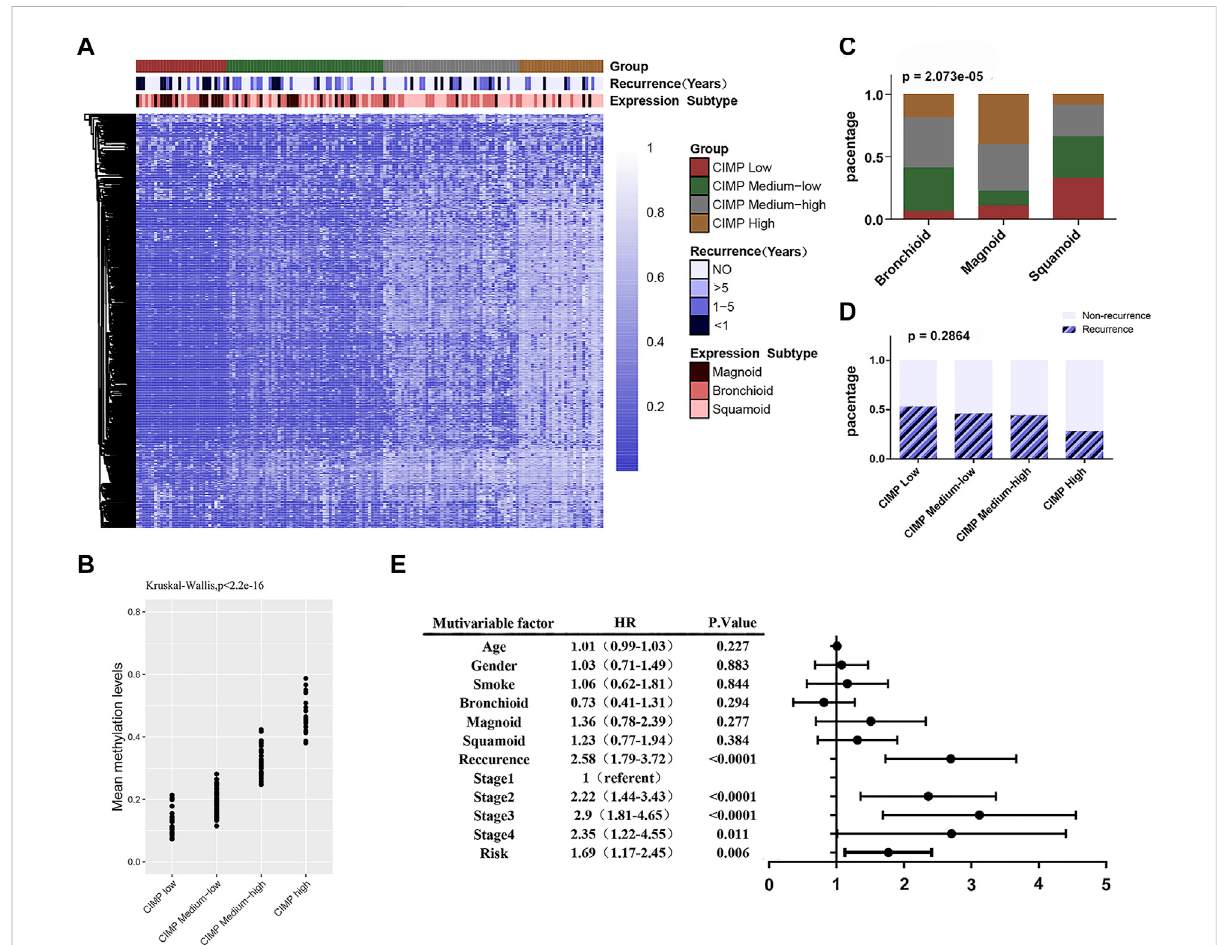
FIGURE 5 The DNA methylation feature with clinicopathological features. (A) Unsupervised cluster analysis of the methylation levels in LUAD. A total of 155 samples are presented in rows, and 641 CpG loci with the largest variation (mean methylation level β < 0.05 in normal samples and standard deviation σ > 0.20 in tumor samples) are listed. The 4 identi fi ed clusters are represented as CIMP high (n = 28), CIMP medium high (n = 45), CIMP medium low (n = 52) and CIMP low ( n = 30). (B) Signi fi cant differences ( p < 0.0001) in the methylation levels of the 4 clusters. (C) The sample distributions in terms of tumor subtype (Chi-square test, p < 0.0001). (D) The sample distributions in terms of recurrence (Chi-square test, p = 0.2864). (E) Forest map: multivariate Cox regression analysis was used to analyze the prognostic values of age, gender, smoking, tumor